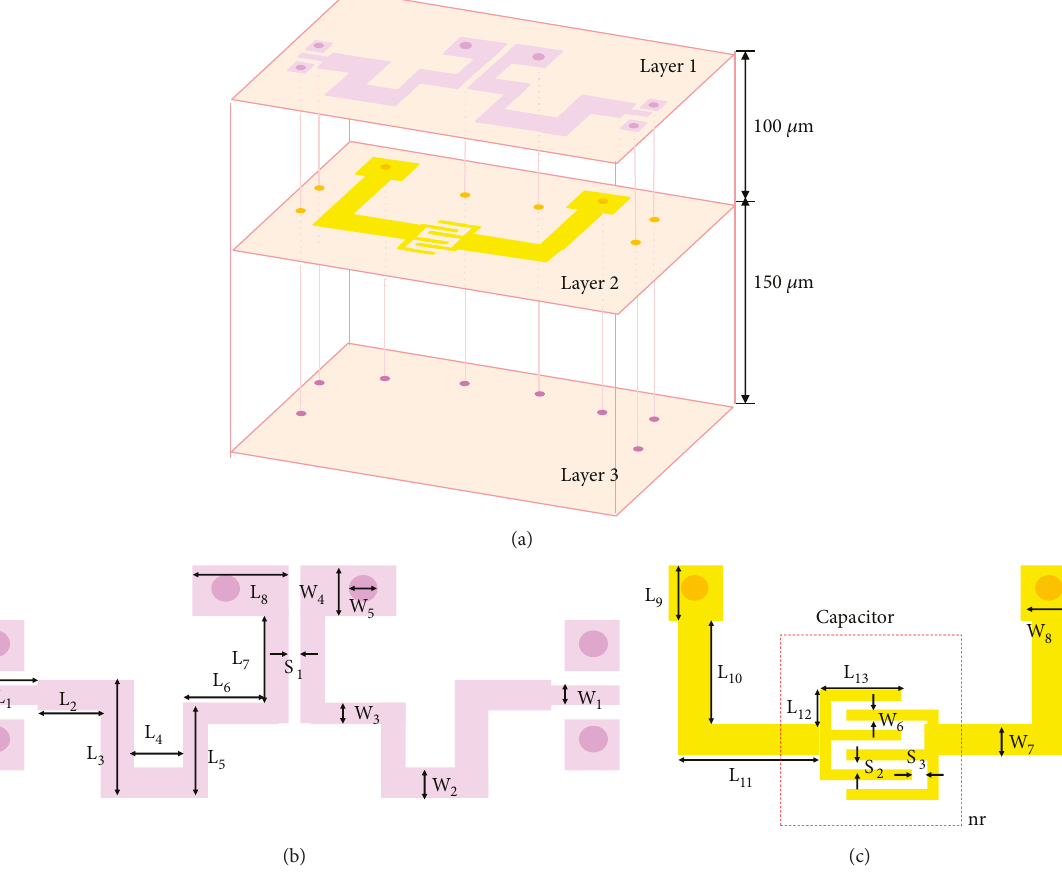
Figure 4: Structure and photograph of proposed bandpass fi